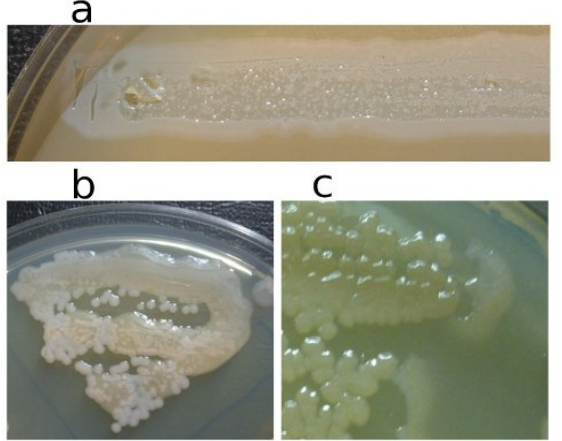
Figure 3. Properties of pseudolysogens which arise after infection of P. aeruginosa PAO1 cells with phage phiKZ. ( a ) the growth of phage phiKZ after two days of incubation, the appearance of opalescence in growth of pseudolysogens; ( b ) replanting of the material taken from growth seen on “a” on the surface of the cultural solid medium; single colonies formed with pseudolysogens after two days of incubation. The colonies produced a lot of mucous material; ( c ) segregation of phage sensitive bacteria and their “runaway” of pseudolysogenic